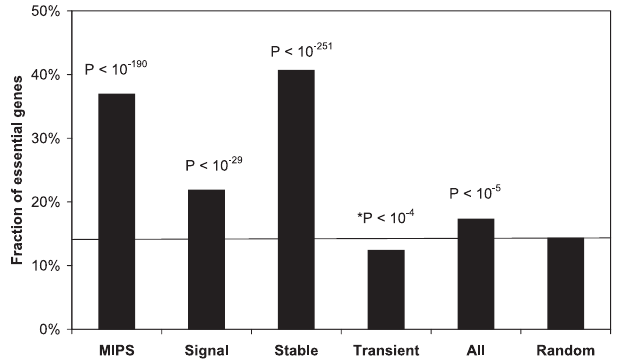
Figure 3. Essentialities of Different Categories of Nonhub–Bottlenecks in the Interaction Network To find all proteins participating in signaling transduction pathways (i.e., the bar ‘‘ Signal ’’ ), we manually went through all available pathways in KEGG and collected all proteins in them. Since this is a very small dataset, we further included all proteins, more than half of whose interacting partners are involved in signaling transduction pathways in KEGG. This inclusion is reasonable because the general belief is that interacting proteins share the same function. The fraction of essential genes among nonhub–nonbottlenecks is used as the random expectation, which is also indicated by the horizontal line. p- Values measure the statistical significance of the different essentialities of different categories of nonhub–bottlenecks relative to the random expectation. The bar ‘‘ MIPS ’’ refers to nonhub–bottlenecks involved in the complexes defined by the MIPS complex catalog. The bar ‘‘ Permanent ’’ refers to nonhub–bottle- necks involved in permanent interactions. The bar ‘‘ Transient ’’ refers to nonhub–bottlenecks only involved in transient interactions. The bar ‘‘ All ’’ refers to all nonhub–bottlenecks. * p- Value above the bar ‘‘ Transient ’’ measures the statistical significance of transient nonhub– bottlenecks being less essential than random.